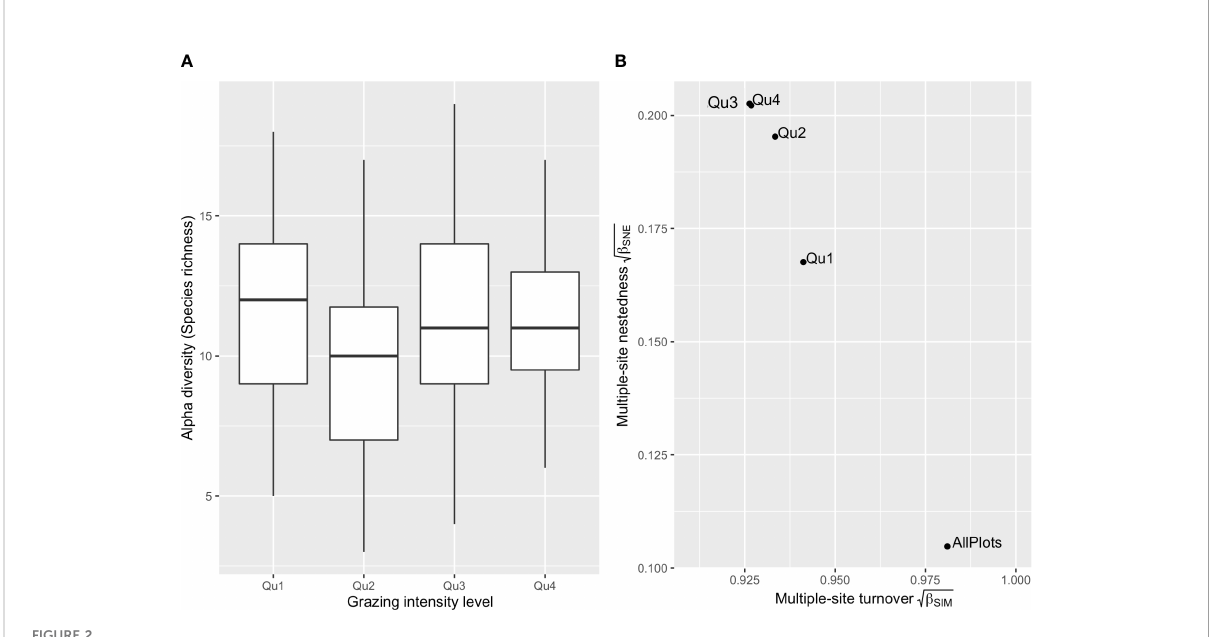
FIGURE 2 Comparing alpha and beta diversities of four livestock grazing intensity levels. Boxplots of plot-scale species richness of the 126 bird assemblages grouped by the four livestock grazing intensity (LGI) quantiles (A) , and incidence-based multiple-site beta diversities of plot groups belonging to the four LGI levels (B) . Beta diversity is partitioned into multiple-site species turnover ( b SIM ) and multiple-site nestedness ( b SNE ). Qu1 indicates the fi rst quantile of the 126 sample plots of low LGIs, and Qu4 is the fourth quantile of high